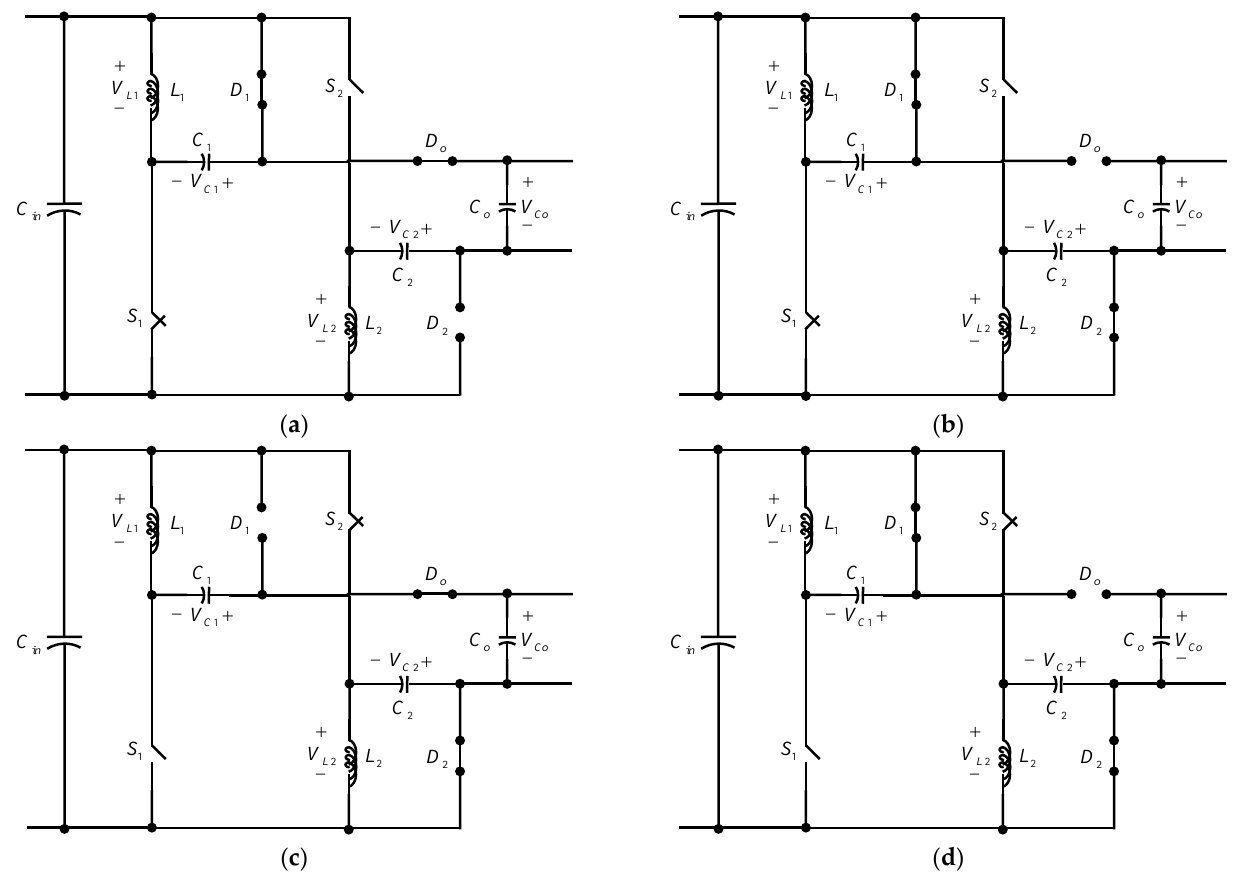
Figure 4. The equivalent circuit of the proposed topology in DCM; ( a ) at